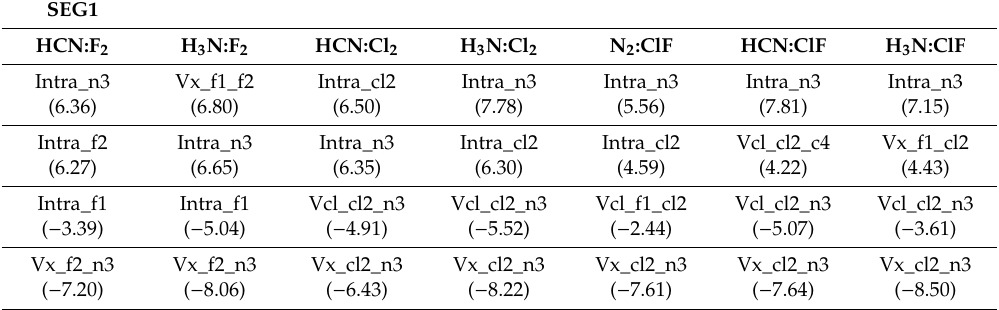
Table 5. REG analysis (level 3) of the total intra-atomic energy, E A , and inter-atomic energies, by all intra types: electrostatic (V cl ), exchange (V x ) and correlation (V c ). For each complex, the largest two energies are listed (most positive and most negative REG value by absolute value except if smaller than